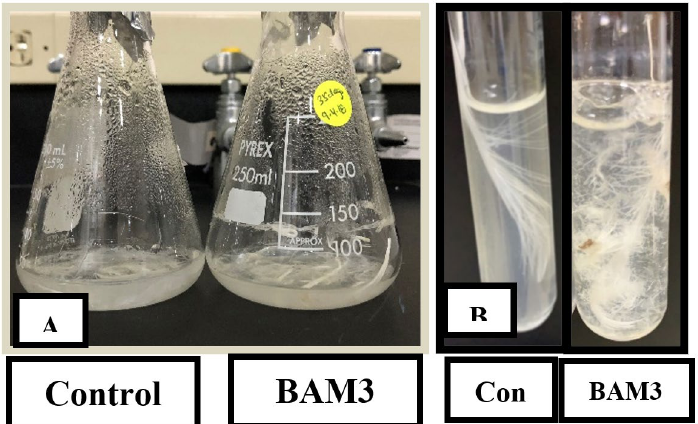
Fig. 3. (A) The flask on the left represents control whereas the flask on the right contains completely degraded feathers by bacterial isolate BAM3 after 10 days in mineral feather medium. (B) Degradation process in one row of the feather